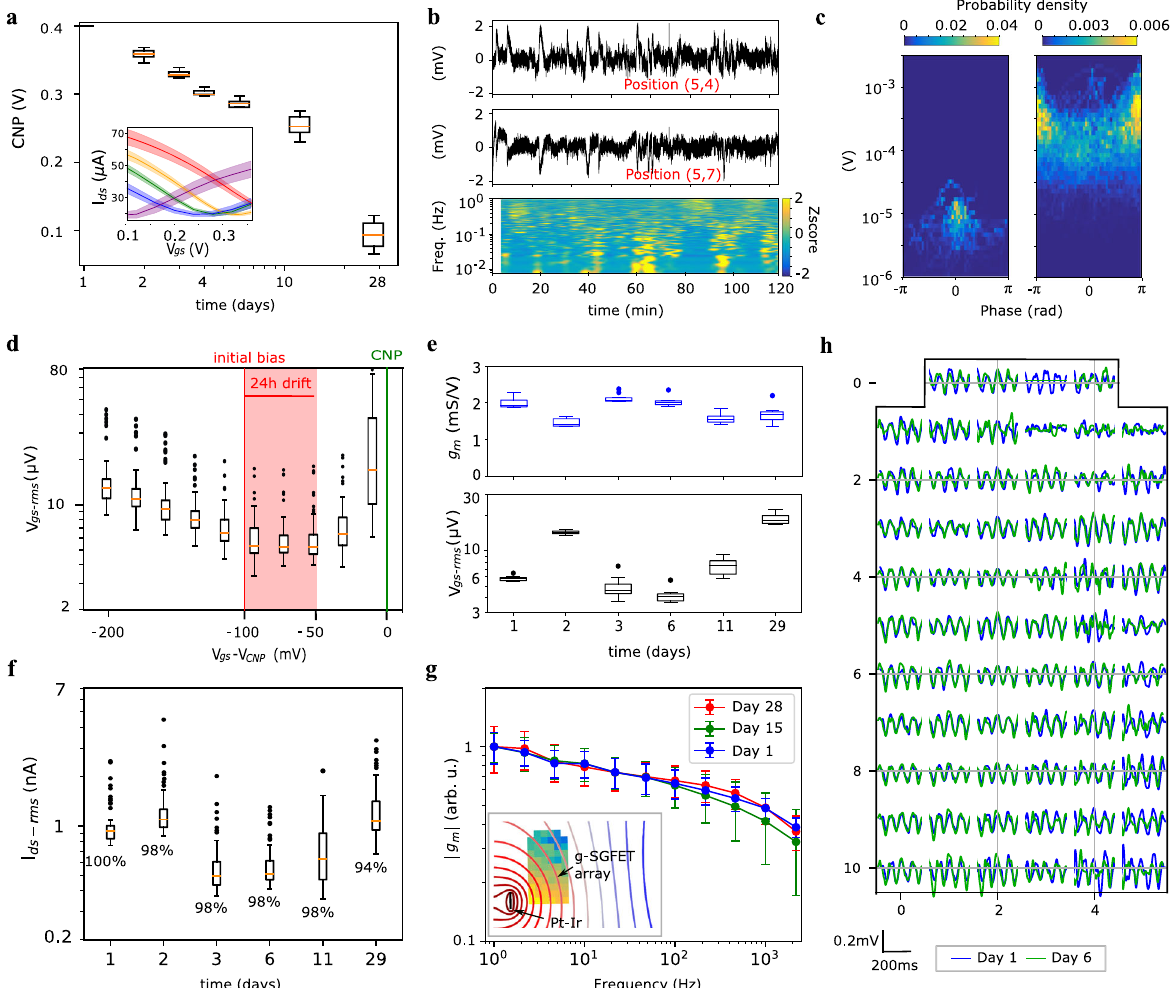
Fig. 3 g-SGFET stability in-vivo. a CNP vs. time over 4 weeks. The inset shows the I ds – V gs curves. Mean and standard deviation for n = 8 g-SGFETs (1 outlier excluded). b Signal from two DC-coupled channels. Indicated positions corresponding to map in panel h . The spectrogram of channel (5,7) is shown (bottom). c The phase-amplitude relation between the channels in panel b , for the noise measured in the beaker (left) and for the signals measured in vivo (right). d Boxplot of V gs-rms vs. shifts in the effective gating ( V gs – V CNP ) of the 64 g-SGFETs. The colored area indicates the measured drift in the CNP referred to a Ag/AgCl electrode during the fi rst 24 h of recording. The initial bias and the CNP are indicated by the red and green vertical lines respectively. e g m (top) and V gs-rms (bottom) measured over 4 weeks post implantation; g m was obtained from the I ds – V gs curves of the DC-coupled channels ( n = 8 g- SGFETs, 1 outlier excluded). f Current noise over 4 weeks after implantation ( n = 64 g-SGFETs). The numeric values indicate the yield of working devices (see supplementary information S4). The boxes in panels a and d – f extend from the lower to the upper quartiles, with a line at the median. The whiskers extend 1.5 times the inter-quartile range and the data points beyond the whiskers are indicated by a dot. g Average and standard deviation of the frequency-dependent transconductance ( |g m | ( f )) shown for different days after the implantation ( n = 10 g-SGFETs). The inset shows the approximate position of the Pt-Ir electrode close to the array, the simulated equipotential contour lines in a conductive plane and the relative signal amplitude measured by each of the g-SGFETs in the array (see supplementary information S5). h Signals measured by all g-SGFETs on the array during a state of increased theta activity on day 1 and day 6 after